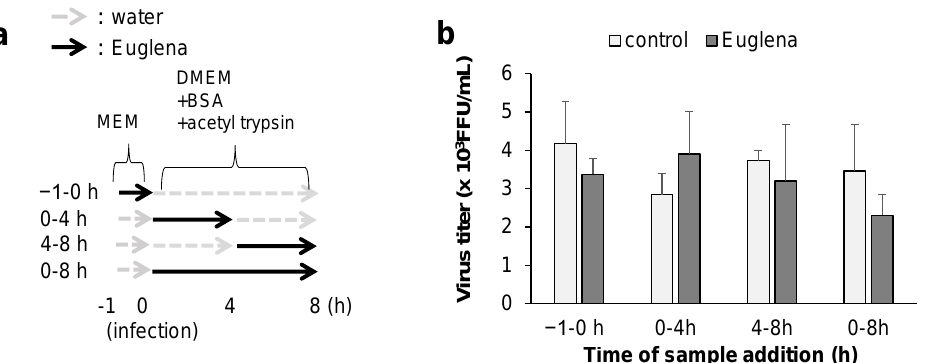
Figure 2. Effect of Euglena extract on the virus titers during its growth cycle. ( a ) Protocol. ( b ) Viral titer in Madin–Darby canine kidney (MDCK) cells infected with influenza virus strain A/PR/8/34, as determined using the focus-forming reduction assay at 8 h after infection. The duration of exposure following the addition of Euglena extract to Madin–Darby canine kidney (MDCK) cells infected with influenza virus strain A/PR/8/34 reflects the growth stage as described in the Methods section. The error bars indicate standard deviation ( n = 3); no significant difference was observed between the extract-treated cells and control cells. FFU: focus forming units.